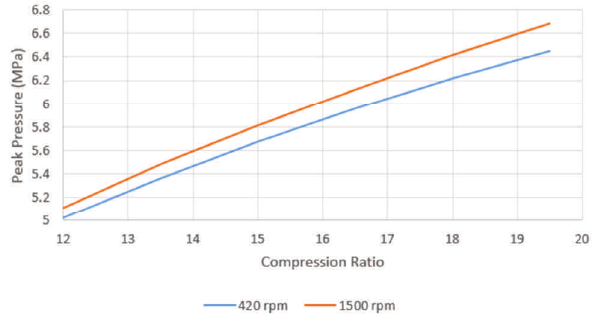
Fig. 6b. Graph of peak pressure against compression ratio